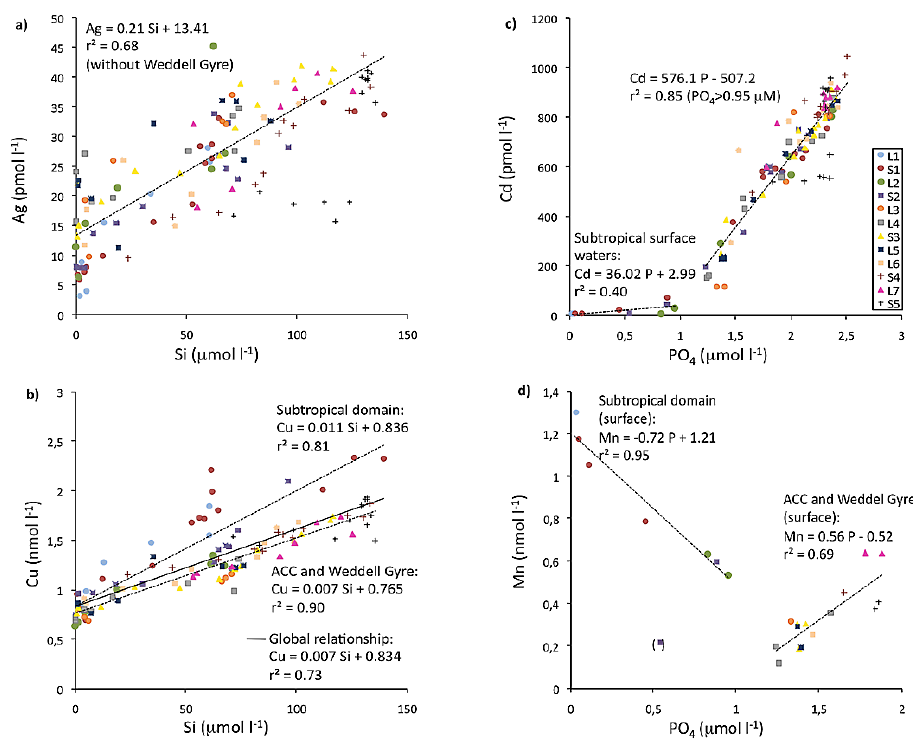
Fig. 7. Relationships among the concentrations of Ag (in pM) (a) , Cu (in nM) (b) and silicic acid (Si; in µM); and Cd (in pM) (c) , Mn (in nM) (d) and phosphate (P0 4 ; in µM) along the section between the southeastern Atlantic and the Southern Ocean. The coloured symbols stand for each